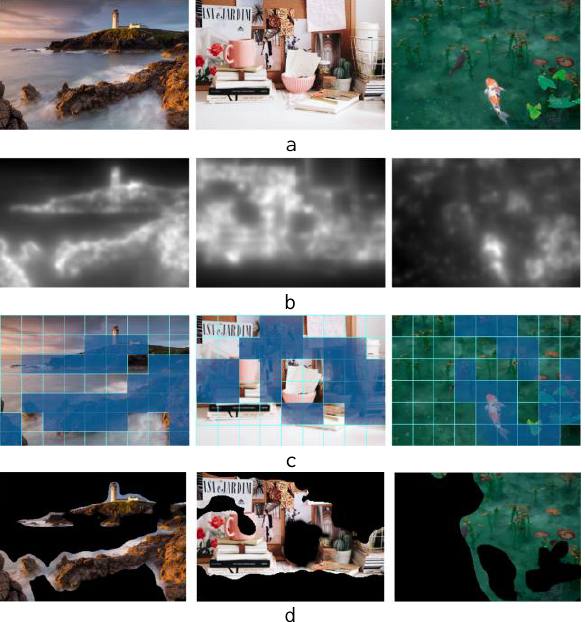
Figure 4 . Examples of watermarking process of the CLIK2019Professonal dataset: a original images, b entropy masks, с patch-based motion masks with 64×64 patch size, d regions for embedding a watermark after excluding fast motion and salient